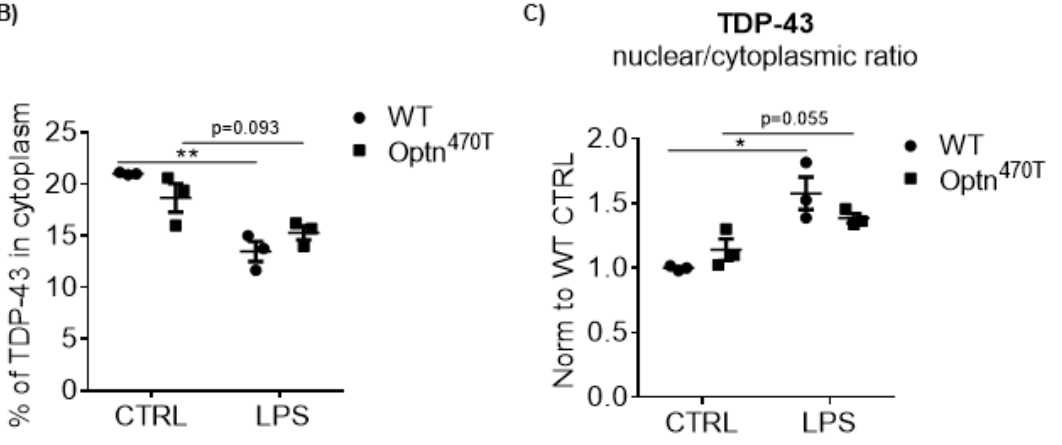
Figure 5. TDP-43 is predominantly nuclear with or without LPS treatment in both WT and Optn 470T primary microglia. ( A ) Representative images of immunofluorescence staining for TDP-43 (red), β -tubulin (green), and DAPI (blue) in WT and Optn 470T microglia in the basal state and stimulated with 2 µ g/mL of LPS for 24 h. ( B ) Graph shows percent of TDP-43 in the cytoplasm in the basal state and upon LPS treatment. ( C ) Nuclear to cytoplasmic ratio of TDP-43 MFI is shown in WT and Optn 470T microglia. An average ± SEM from 3 independent experiments is shown. Statistical analysis was performed by Student’s t -test: * p < 0.05, ** p < 0.01. Scale bar = 20 µ